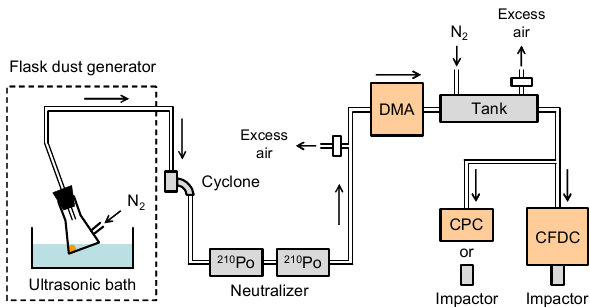
Figure 1. Schematics of the freezing experiment system. Dry dust particles were generated from the flask dust generator. The DMA selected particles with a mobility diameter of 600nm for analysis by the CPC and CFDC. Impactors were used for direct sampling of the total particles and ice-nucleating